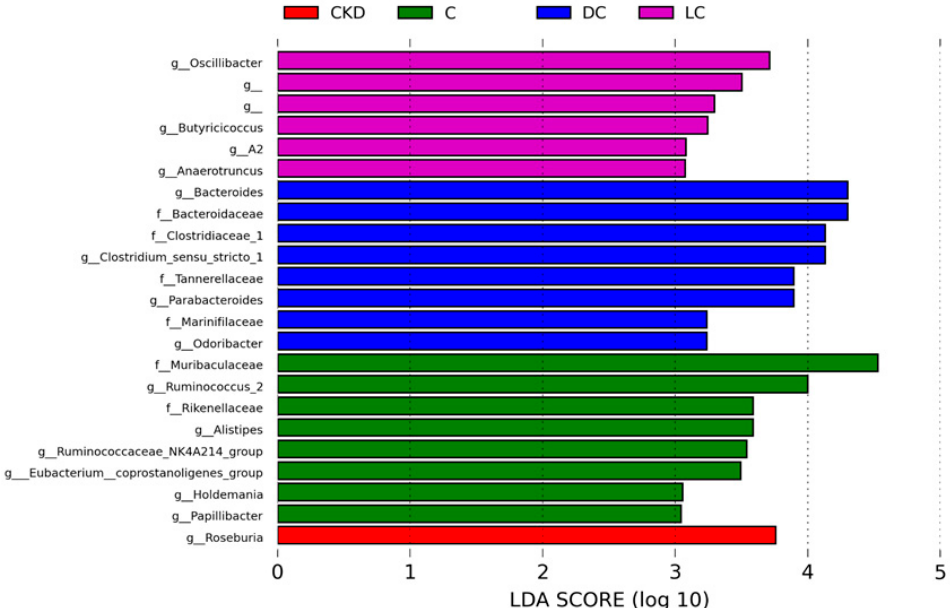
Figure 7. Linear discriminant analysis effect size (LEfSe) was assessed for biomarker discovery. Most enriched bacterial taxa in the C (green), CKD (red), LC (purple), and DC (blue) groups are illustrated. The linear discriminant analysis (LDA) score threshold was set to greater than 3.